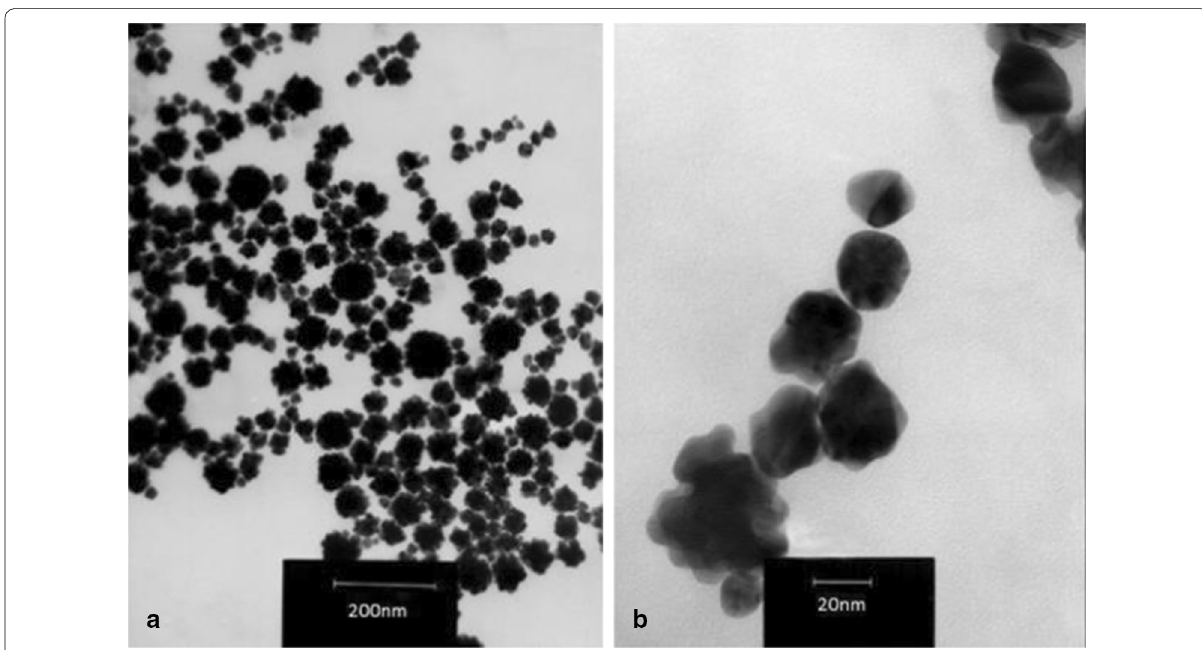
Fig. 3 TEM micrographs that were obtained from the biologically produced GNPs. a scale bar micrographs, the nanoparticles had hexagonal shapes with average sizes of about 50